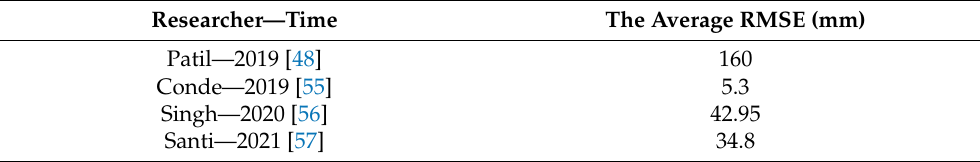
Table 7. Comparison of snow water equivalent accuracy among different researchers.